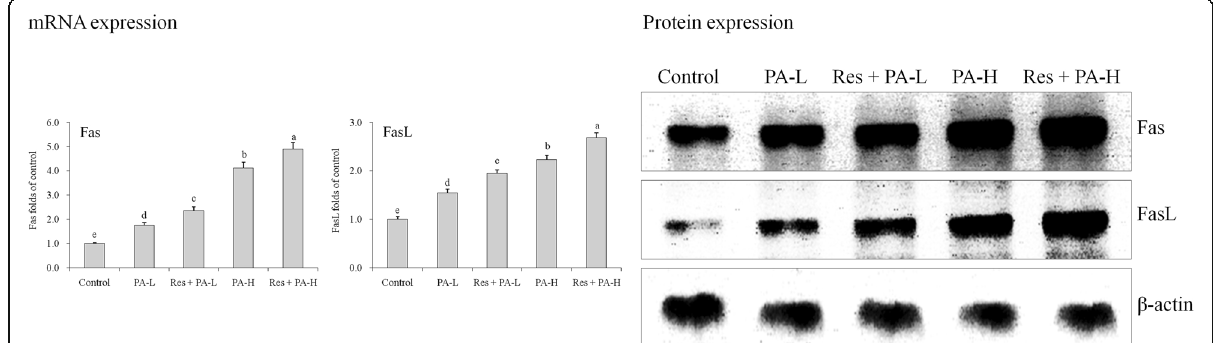
Fig. 6 The mRNA and protein expression of Fas and FasL in HepG2 human liver cancer cells. a-e Mean values with different letters over the bars are significantly different (P < 0.05) according to Dunnett ’ s post-hoc test. PA-L: 5 μ g/mL of paclitaxel; Res + PA-L: 10 μ g/mL of resveratrol +5 μ g/